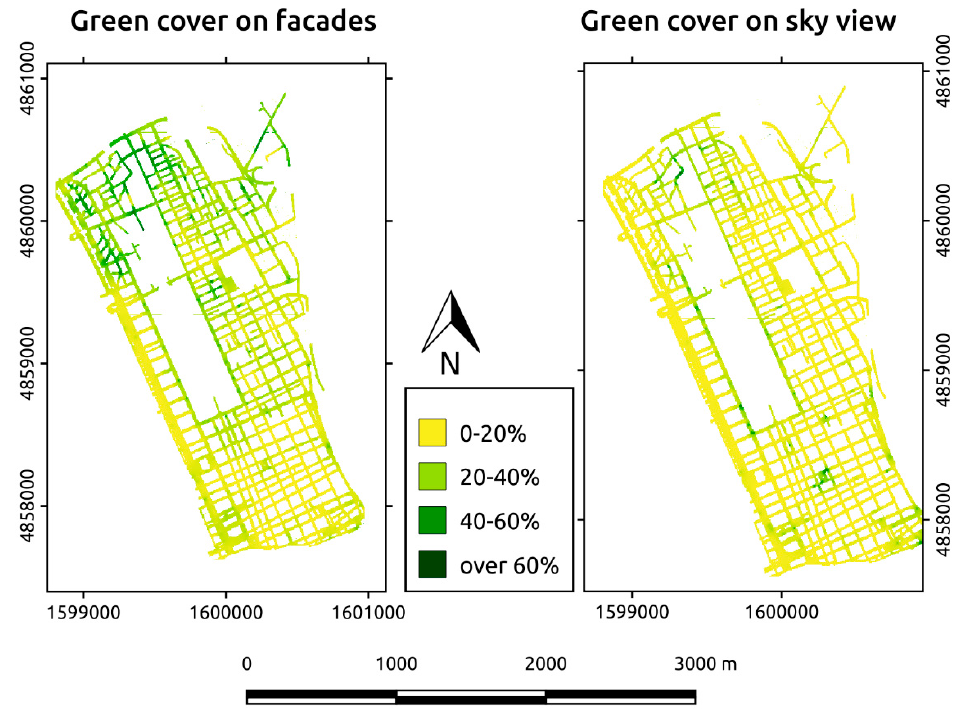
Figure 8. Maps of Grenn Cover on Facades (GCF) and Green Cover on Sky (GCS ) i ndices.